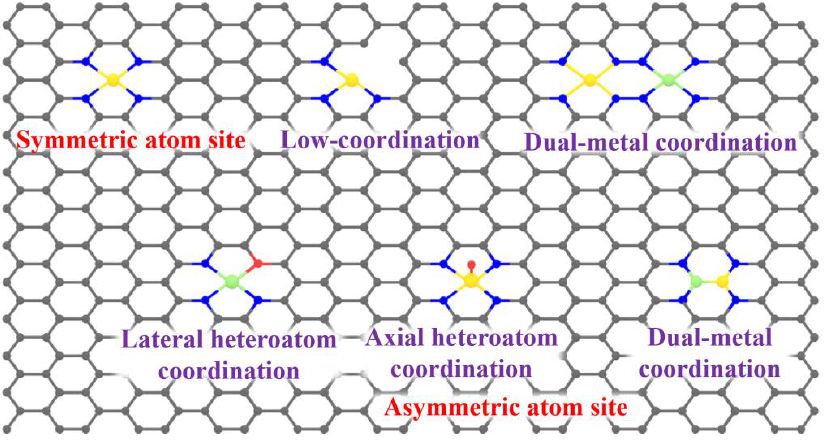
Figure 1. Model illustration for the symmetric/asymmetric atom sites (yellow and green, metal atom; blue, N atom; gray, C atom; red, heteroatom, such as O, P, S etc.).